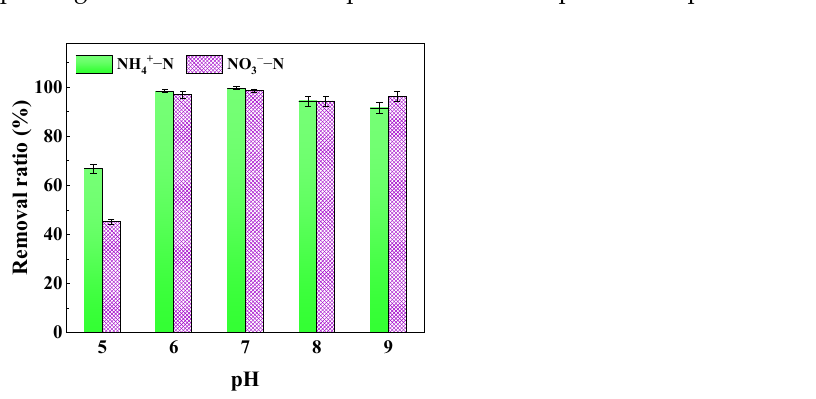
Figure 5. Influence of C/N on nitrogen compounds removal on Vibrio sp. LY1024.